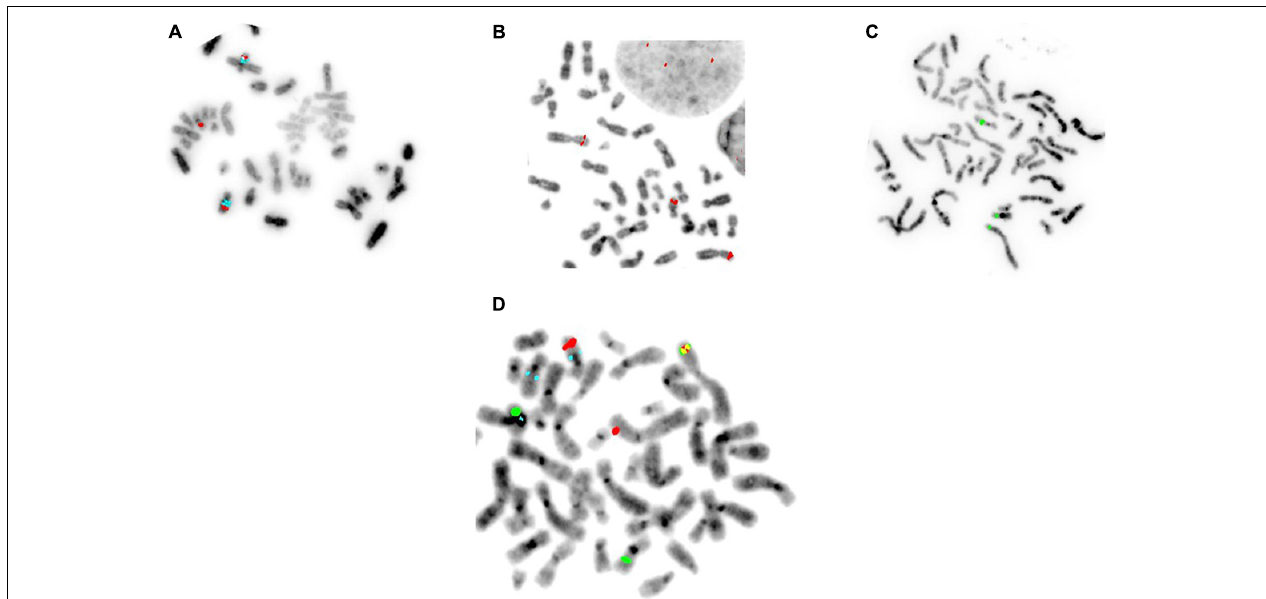
FIGURE 2 | Specific FISH-EA probes for the translocation event(s) seen in the BEC model. Multiple probes for the same loci were tested to find the ideal probe spanning the breakpoints. (A – C) The ideal probes for Chr2 and Chr16, respectively. (D) Combining two FISH-EA probes specific for breakpoints on Chr2p22 (red) and Chr16q22 (green), respectively, the fusion could be visualized as a yellow signal resulting from the fusion of the two partial segments of the probes complementary to the respective chromosome sequences. A segment of Chr2 (red) is translocated to Chr10 (marked by aqua centromere probe).